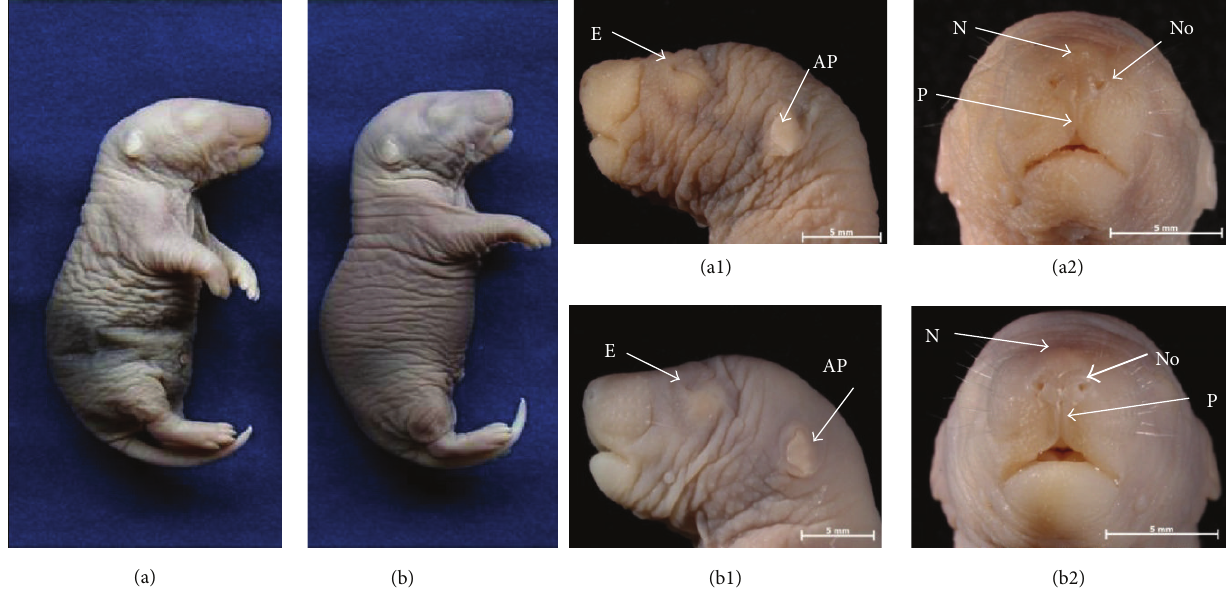
Figure 3: The body and facial morphologies of newborn pups obtained from control rats ((a), (a1), and (a2)) and streptozotocin-induced diabetic rats ((b), (b1), and (b2)). Note in the pup from the diabetic mother (b1) the medial surface of the helix with the straight edge in the auricular appendage. E = eyelids, AP = auricular pavilion, No = nostrils, N = nose, and P =